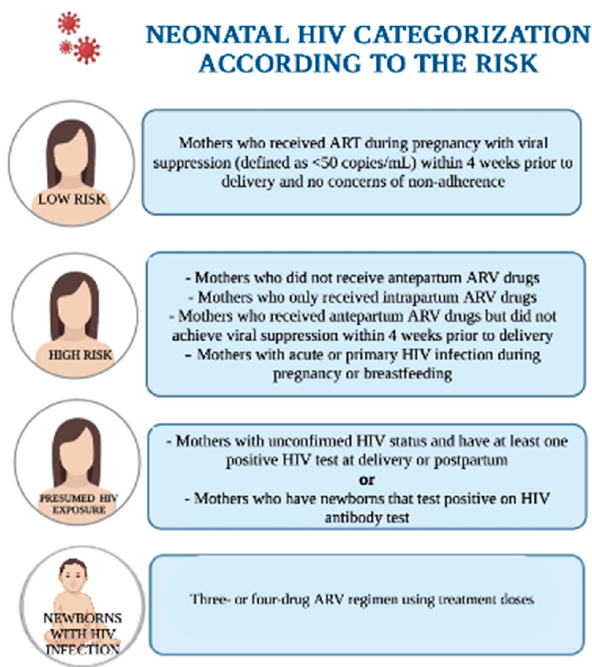
Figure 3. “Neonatal HIV Categorization According to the Risk”. Adapted from Recommendations for the Use of Antiretroviral Drugs During Pregnancy and Interventions to Reduce HIV Transmission in the United States. 30 December 2021. Created in BioRender.com.